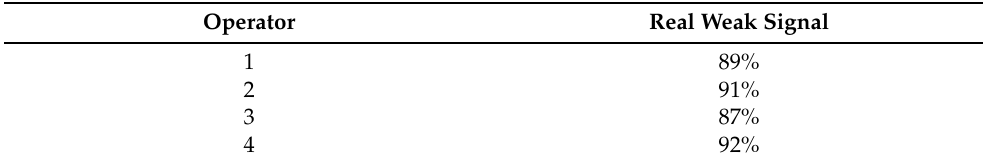
Table 3. Percentage of OSN complaints that correspond to a weak signal found according to the ANATEL database.